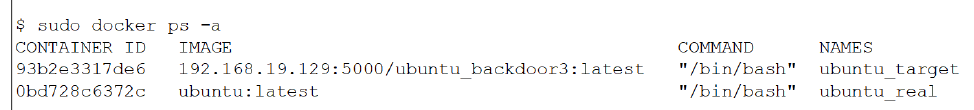
Figure 30. ubuntu_target docker container list accessed from ubuntu_attacker (2).